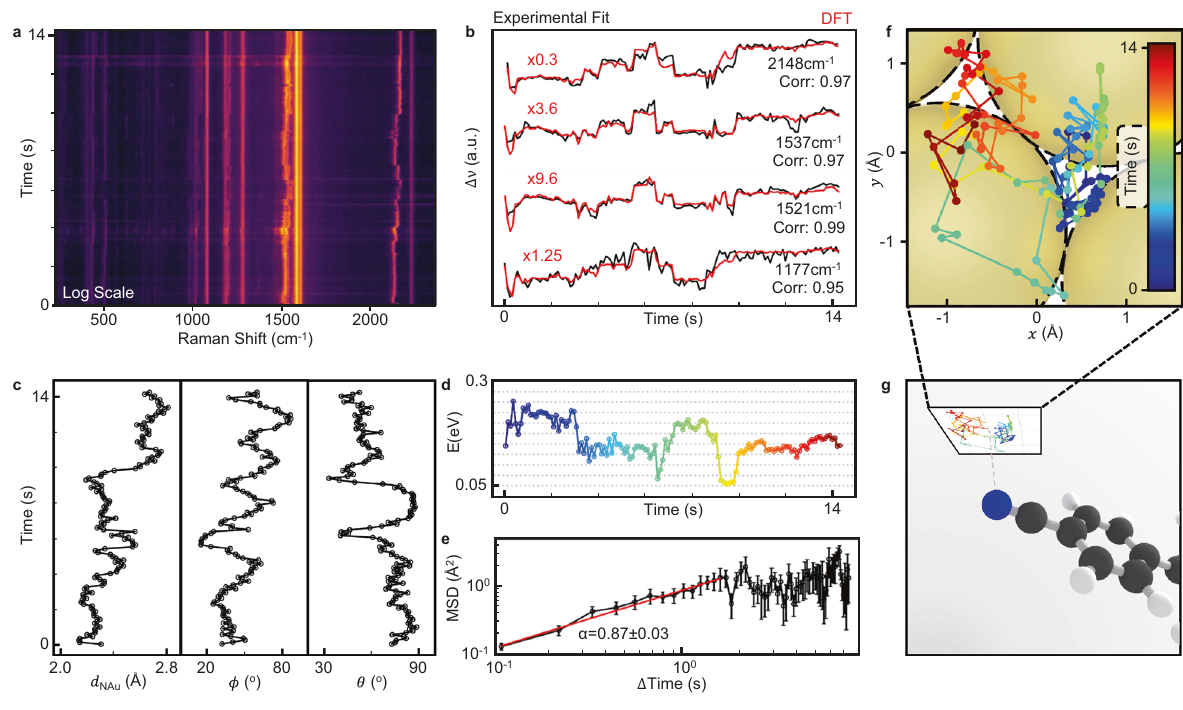
Fig. 3 Adatom track to recreate experimental spectra. a Experimental picocavity spectra taken with 300 µ W 633 nm laser power for 100 ms integration time (log scale). Time starts when picocavity fi rst forms. b Extracted picocavity peak positions, overlaid with corresponding peak positions from an optimised adatom trajectory in DFT. These are plotted on individual scales to emphasise the shape of the peak trajectories and the DFT is scaled to overlay (red). High Spearman correlations show good agreement for each peak. c Extracted adatom coordinates for this trajectory. d DFT system energy along adatom trajectory. Colour refers to time colour bar. e Mean square displacement (MSD) of adatom with increasing time window, showing anomalous sub- diffusion on < Å scales. Error bars indicate standard error. f Adatom trajectory projected onto a plane, with FCC lattice of underlying nanoparticle facet overlaid and g plane shown relative to molecule in 3D. Colours match those in ( f ) indicating